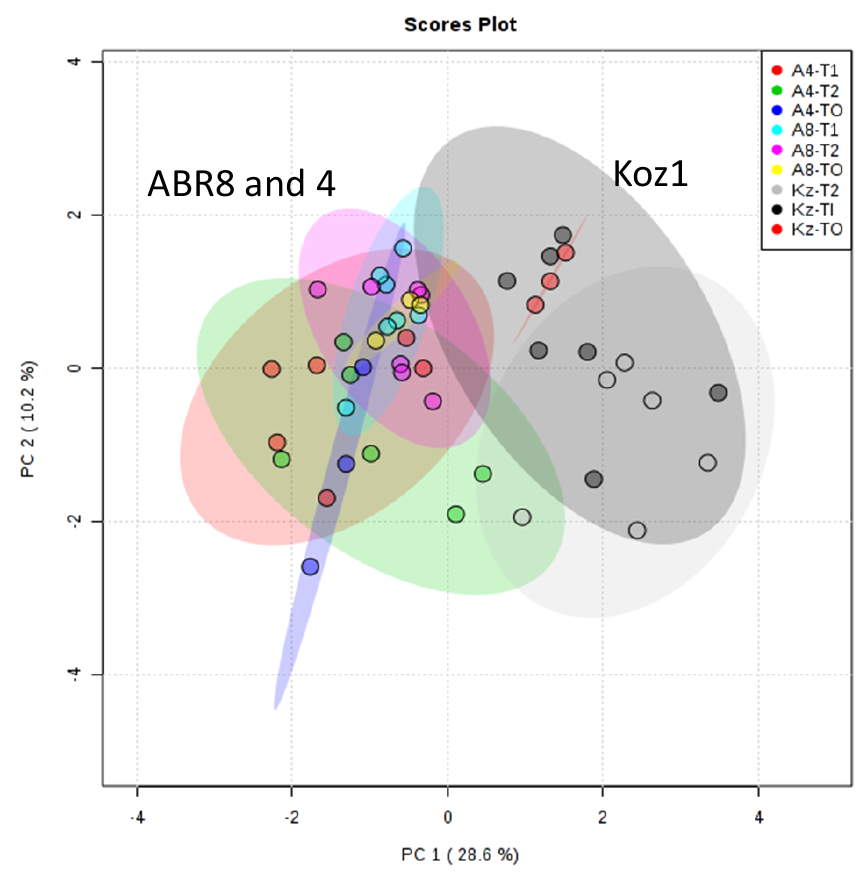
Figure 7. Principal Component Analysis (PCA) of metabolite profiles of the three Brachypodium Figure 7 . Principal Component Analysis of metabolite profiles for the genotypes (ABR4 [A4], ABR8 [A8] and KOZ1[KZ]) in response to drought stress after 4 days (T1) and 8 three Brachypodium distachyon genotypes (ABR4 [A4], ABR8 [A8] and days (T2) of withholding water compared to well-watered controls KOZ1[KZ]) in response to drought stress after 4 days (T1) and 8 days (T2) of with-holding water compared to well –watered controls (T0)